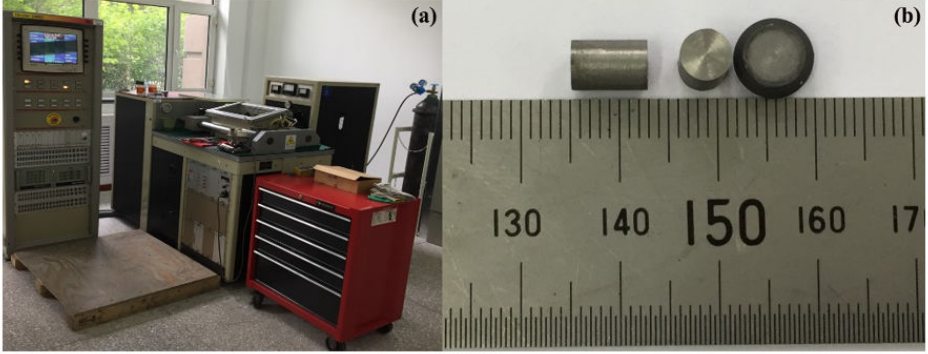
Figure 4. Hot compression simulation: ( a ) Gleeble-1500D system; ( b ) Hot compression simulation